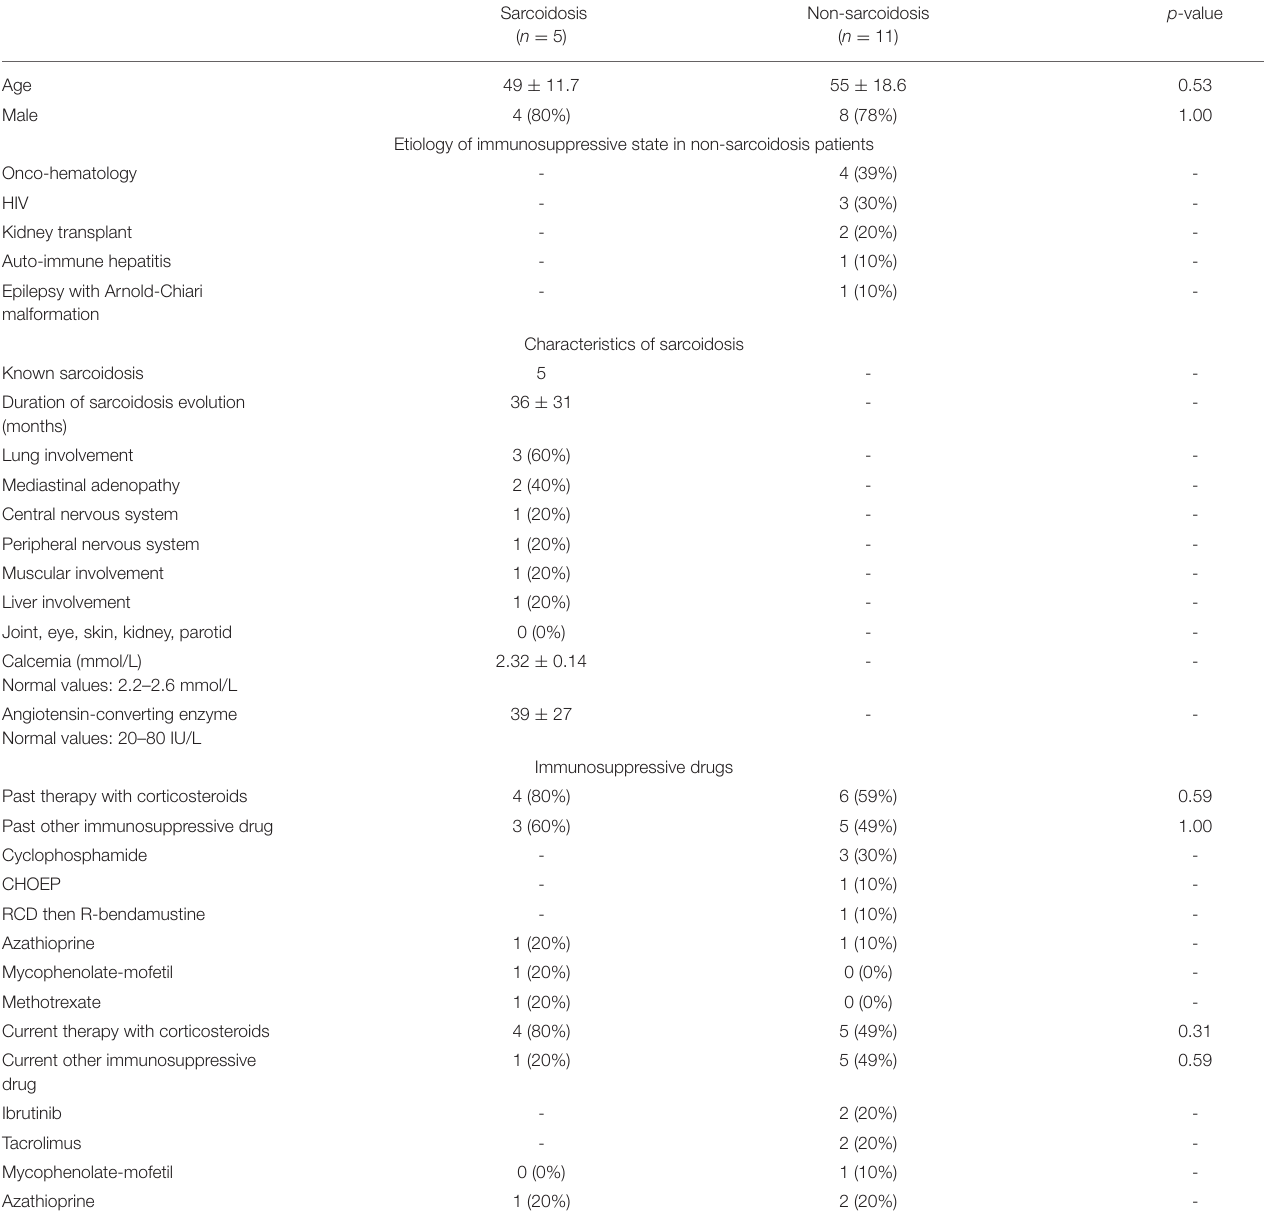
TABLE 1 | Characteristics of patients diagnosed with Cryptococcus sp. infection of the central nervous system.